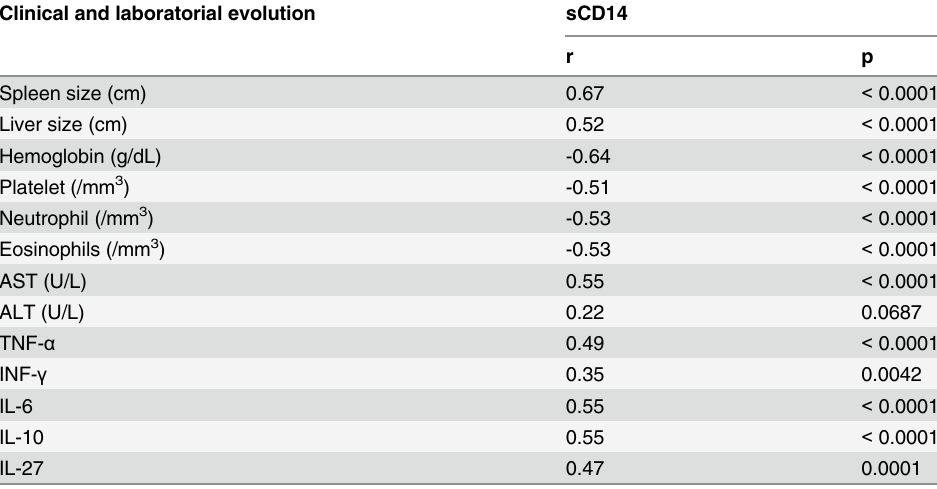
Table 3. Correlation coefficients of sCD14 levels and clinical, hematological data and cytokine con- centrations of the all